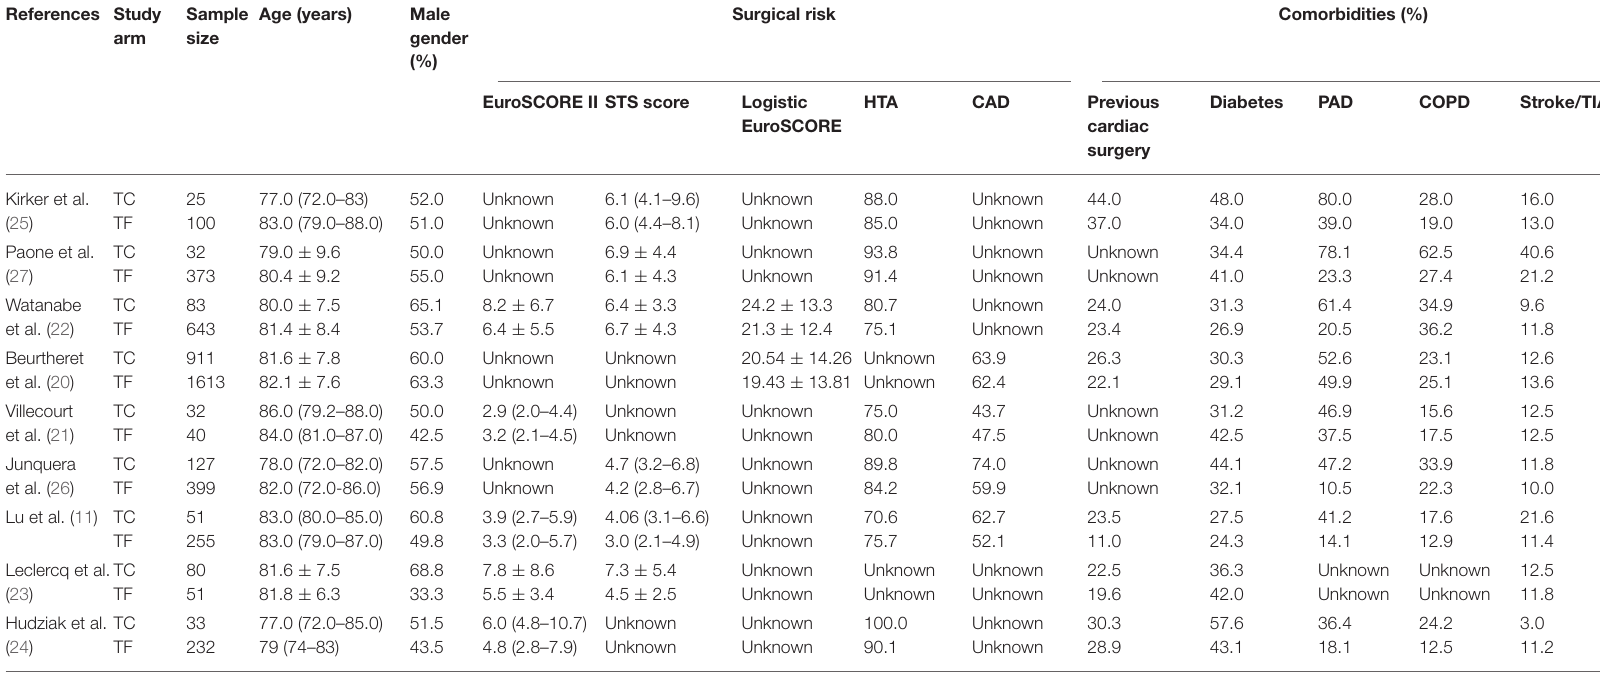
TABLE 1 | Characteristics of patients undergoing transcarotid transcatheter aortic valve